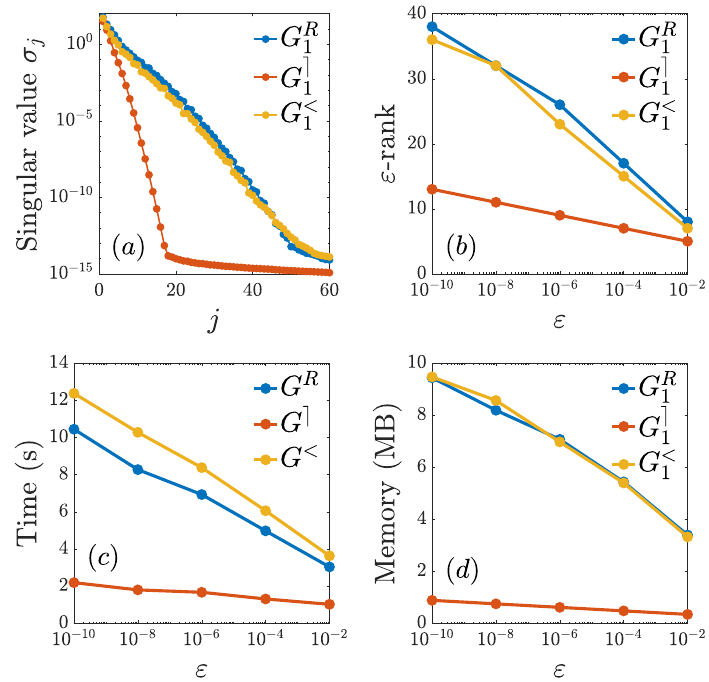
Figure 5: Varying the SVD truncation tolerance (cid:34) for the ramp example with prop- agation time T = 64, corresponding to N = 4096 time steps. We plot (a) singular values of the largest block in the hierarchical partition for G R the ranks of the compressed representations for G component of G , and (d) the memory required to store each component of G